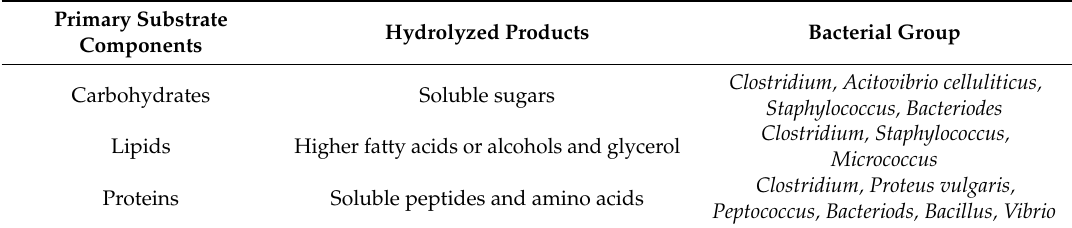
Table 1. Bacterial groups involved in hydrolysis of different substrate components [16].